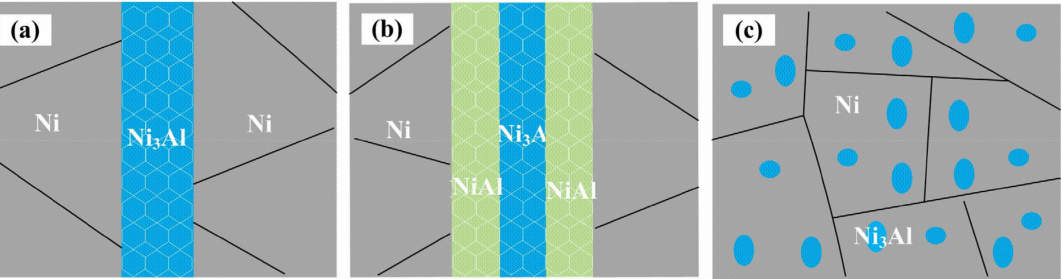
Figure 12. Microstructure schematics of different phase structure forms. ( a ) Dual-phase with Ni matrix layer phases that contains Ni 3 Al layers; ( b ) ternary-phase with Ni matrix layers phase that contains Ni 3 Al and NiAl layers; ( c ) dual-phase with Ni matrix phase that contains Ni 3 Al